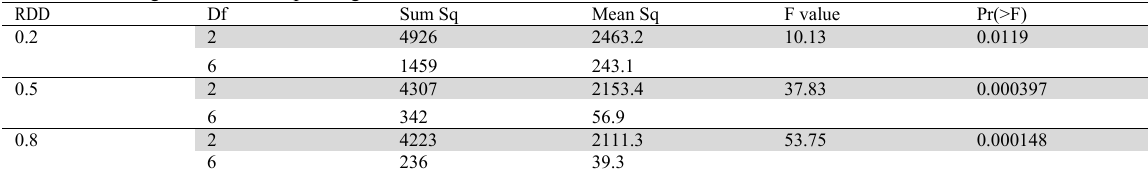
ANOVA of average RDI values depending on